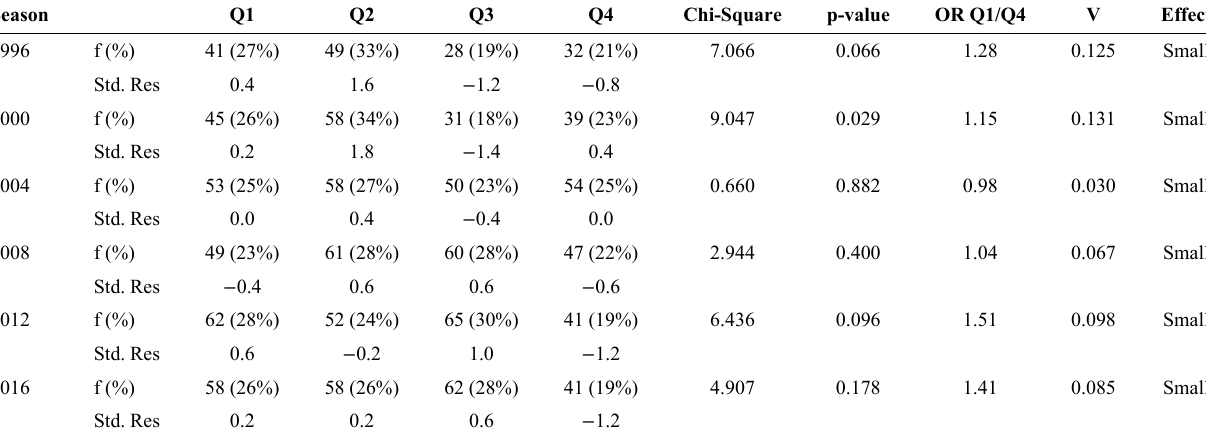
Table 2 - Distribution of the birth months of women's football players in Summer Olympic Games. Season Q1